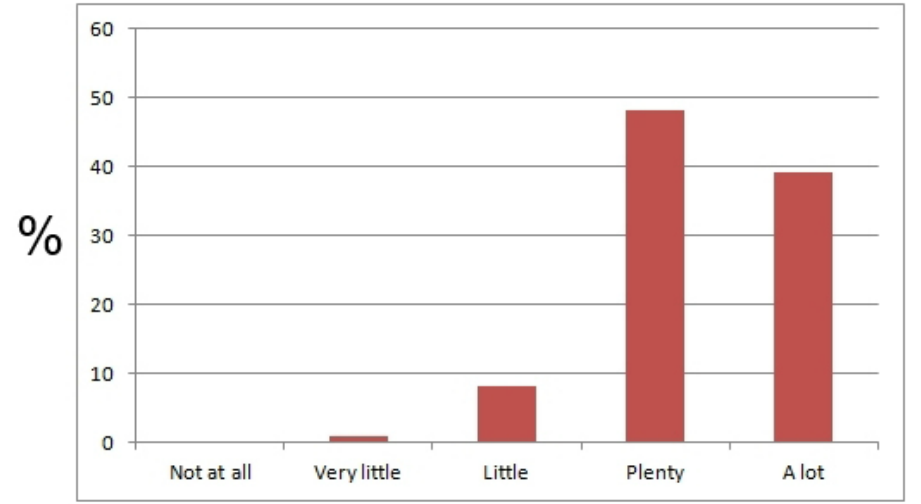
Figure 5. Students enrolled in the course filled in online surveys about how many useful suggestions the course provided them with. The y axis represents the percentage of students that chose the particular answer.